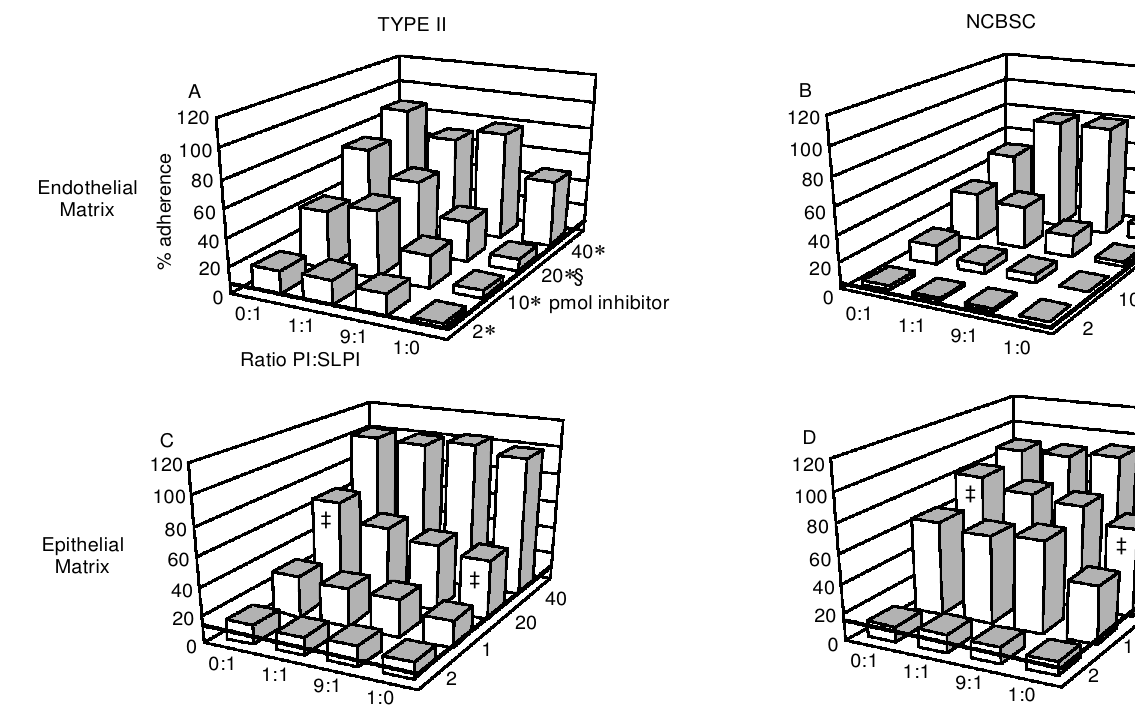
FIG. 5. Comparison between the inhibitory effect of PI and SLPI on 24 pmol NE and the ability of freshly plated cells to adhere to endothelial matrix and epithelial matrix. The solid line represents NE alone while the bars represent NE in the presence of inhibitor. = signi® cant prevention of the effect of NE on type II cell adherence to endothelial matrix by either PI or SLPI; inhibitor levelÐ 40 pmol ( P , 0.001), 20 pmol ( P , 0.001, excepting PI alone), 10 pmol ( P , 0.001, excepting PI alone) and 2 pmol ( P , 0.05, excepting PI alone); † = signi® cant prevention of the effect of NE on NCBSC adherence to endothelial matrix by PI combined with SLPI; inhibitor level 40 pmol ( P , 0.001), 20 pmol ( P , 0.001) and 10 pmol ( P , 0.05, SLPI alone); § = signi® cantly enhanced inhibition of the action of NE on epithelial cell adherence to endothelial matrix by SLPI compared with PI; inhibitor level 20 pmol, P , 0.001; ‡ = signi® cantly enhanced inhibition of the action of NE on epithelial cell adherence to epithelial matrix by SLPI alone compared with PI alone: inhibitor level 20 pmol, P ,